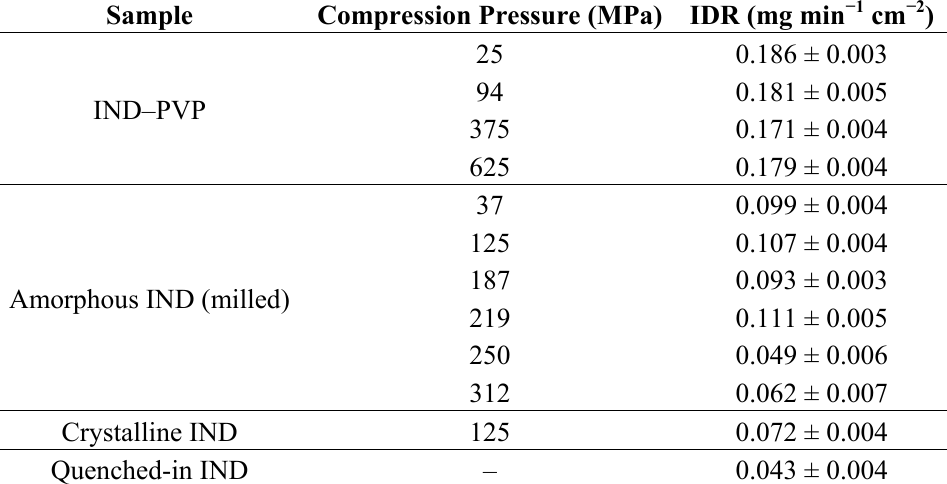
Table 1. IDR determined from the slopes of the dissolution profiles for IND–PVP, amorphous IND and crystalline IND compact as well as from the quenched-in IND discs.